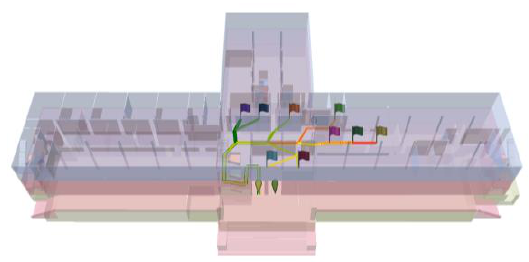
Figure 15. Generated Evacuation 2nd Floor